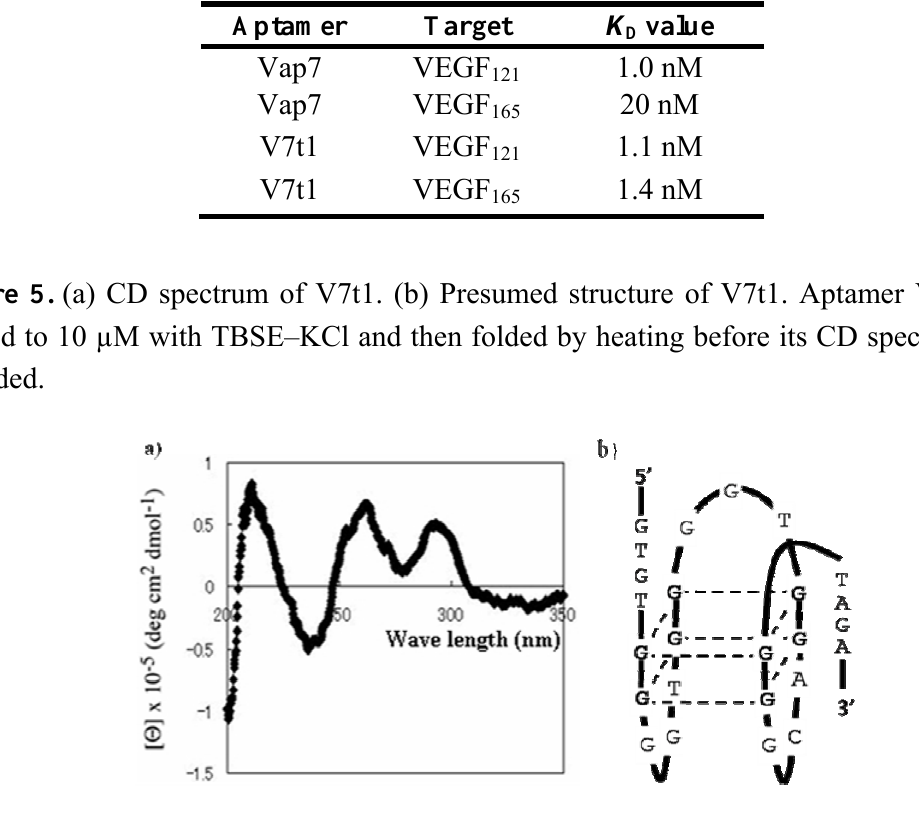
Table 3. Dissociation constants of the aptamers against the VEGF families. The dissociation constants ( K ) were calculated by using the data sets obtained from the SPR D measurements.